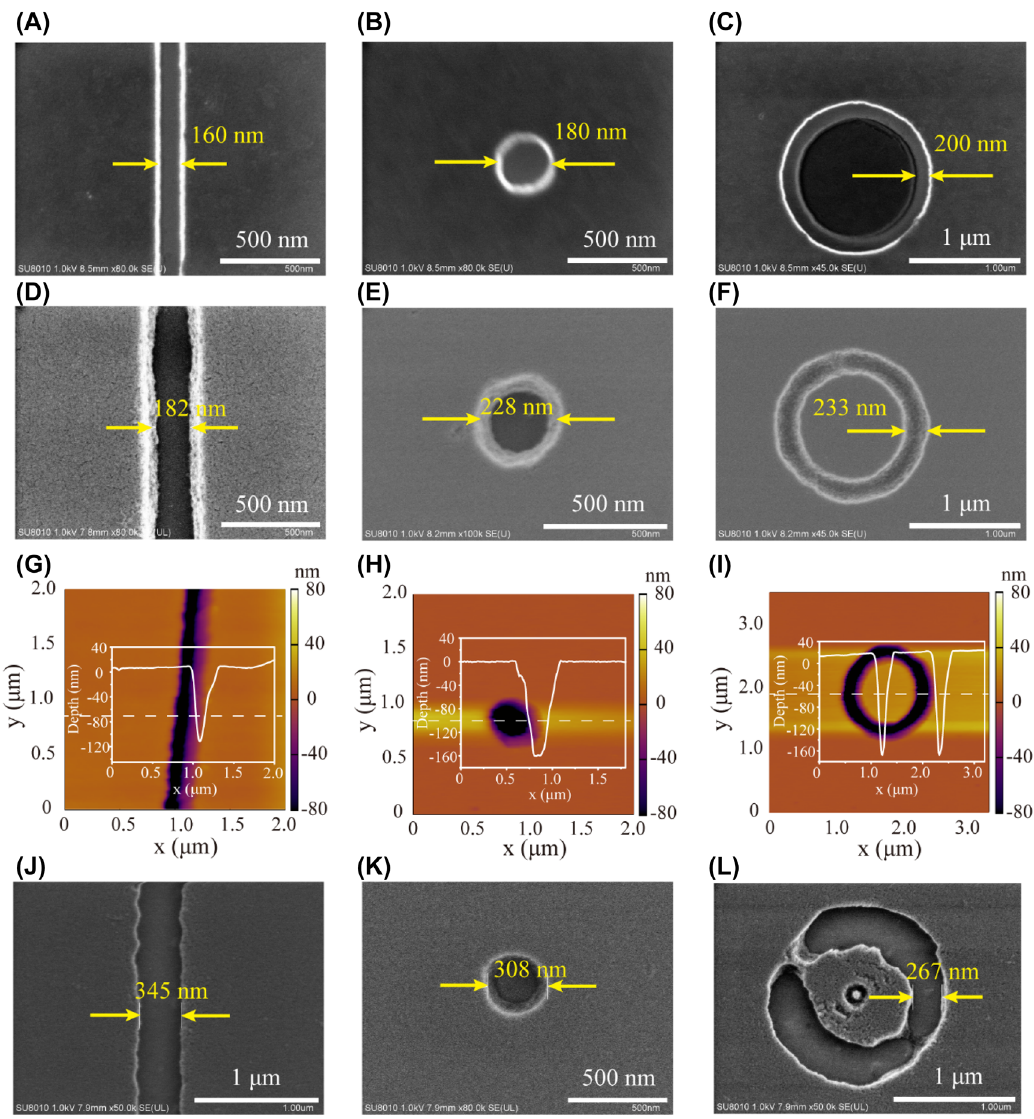
Figure 5: Experimental results of typical mask patterns in lithography with/without NIM multilayer. (A – C) SEM images of the masks with a straight slit, isolated aperture, and annular slit, respectively. (D – F) Corresponding SEM images of the patterns formed in PR. (G – I) Corresponding AFM images of the PR patterns. The insets present the depth profilesalong the dashed lines. (J – L) Corresponding SEM images of the PR patterns in control